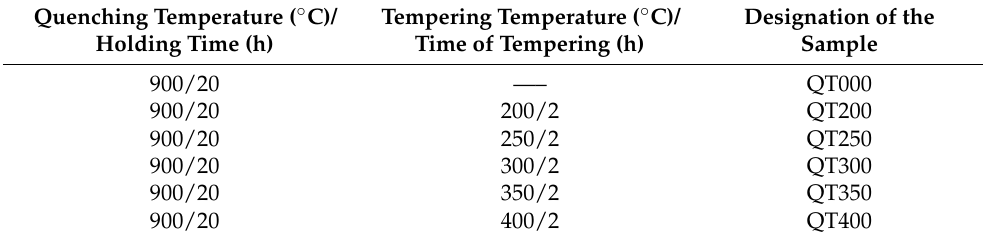
Table 2. Quenching and tempering